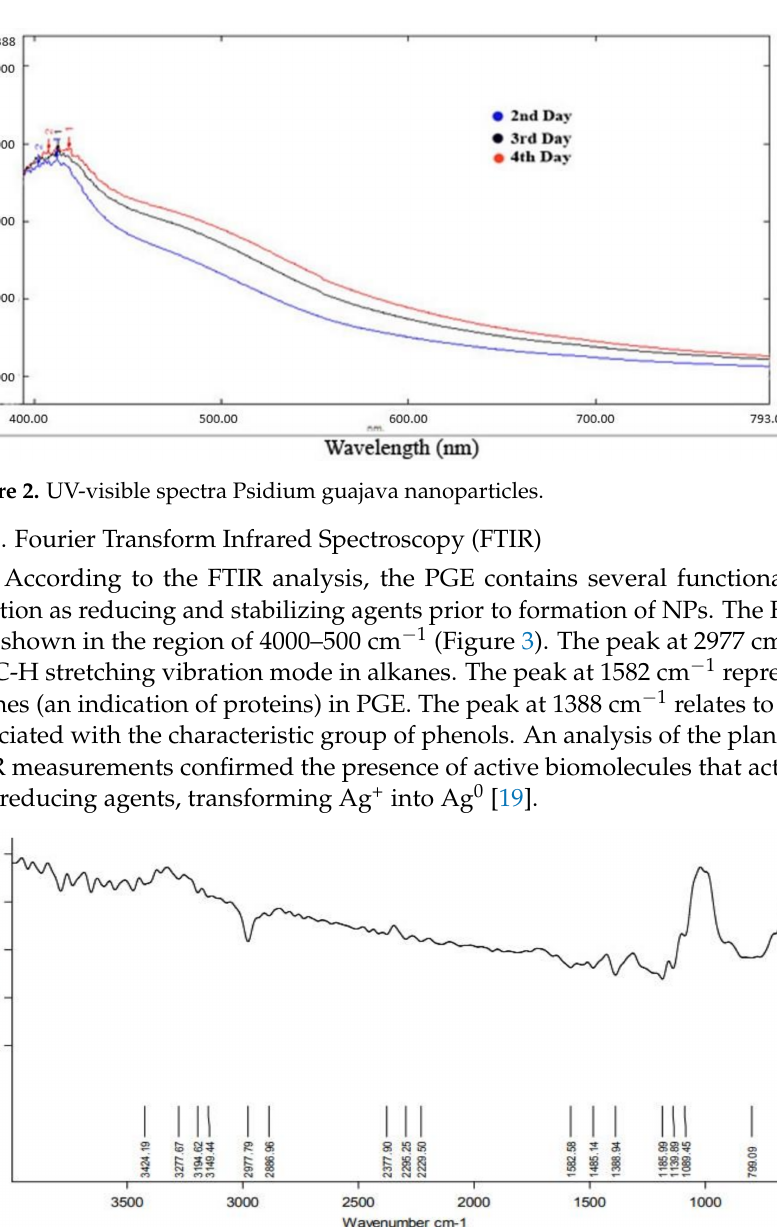
Figure 1. Color changing results in formation of PGAg NPs at ( A ) 0 h, ( B ) 24 h, and ( C ) 48 h.